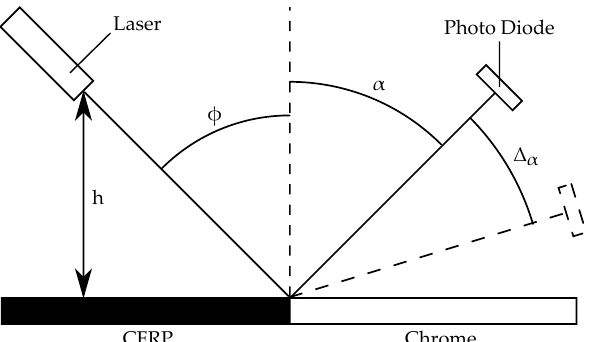
Figure 6. Schematic of the measurement setup for directional reflectivity measurement of painted surfaces. The ray tracing simulation setup also follows this arrangement.